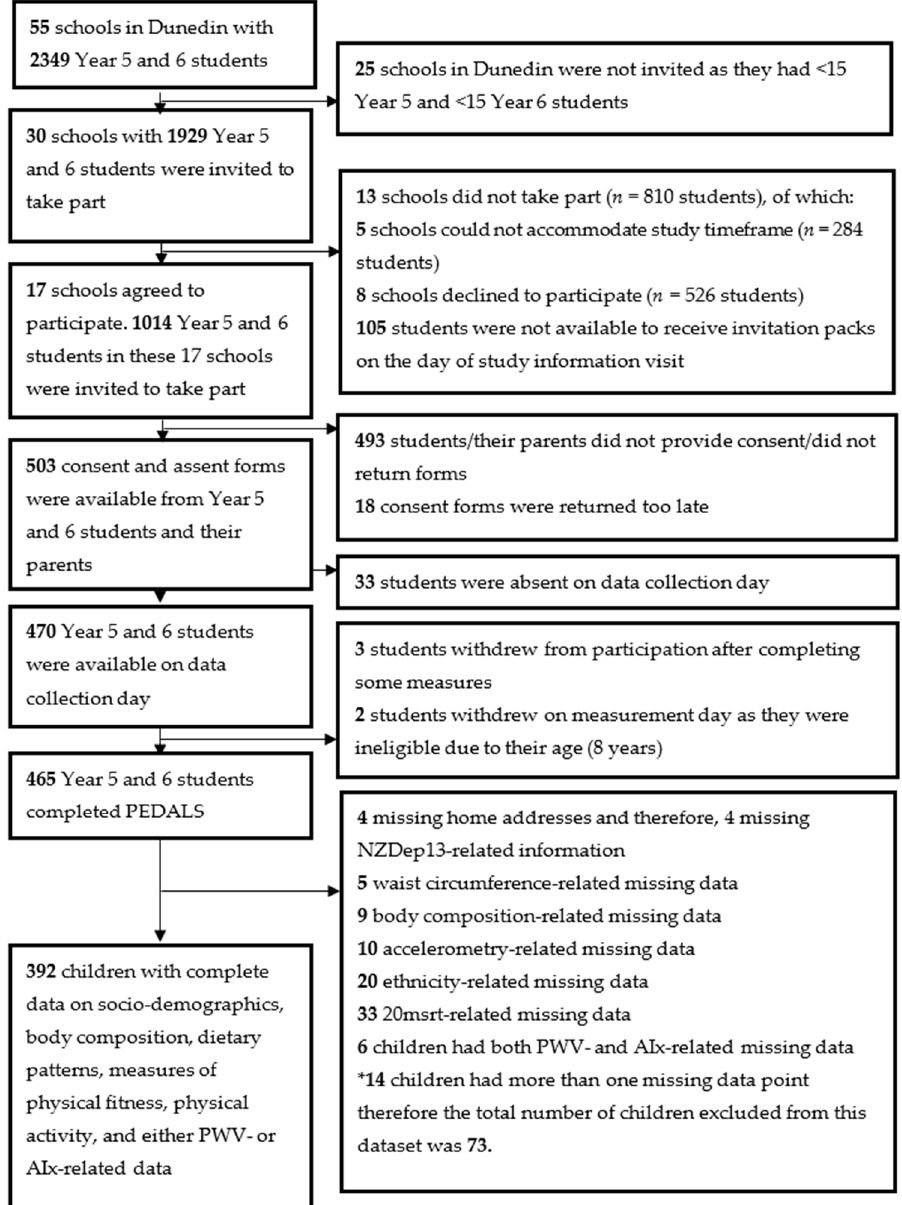
Figure 1. Study sample selection (schools and children) in the Physical activity, Exercise, Diet, And Lifestyle Study (PEDALS).